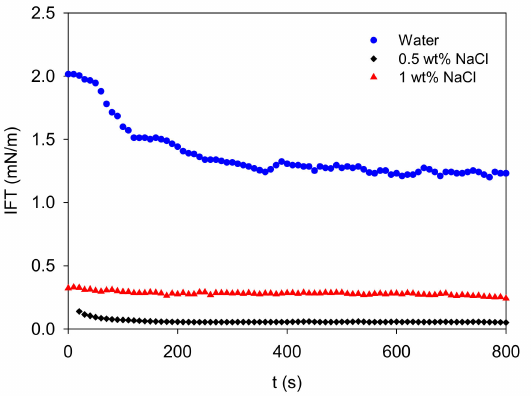
Figure 4. Effect of NaCl concentration on dynamic IFT between crude oil and formulations with 1 wt% eutectic mixture (AOT + PEG-600).